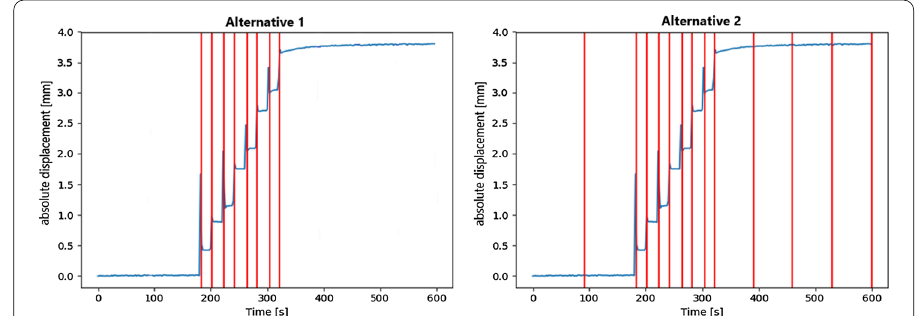
Fig. 10 Schematic representation of the motion-adapted frames for Alternative 1 (left) and for Alternative 2 (right). The blue line represents the absolute translation amplitude and the red lines symbolize the frame boundaries